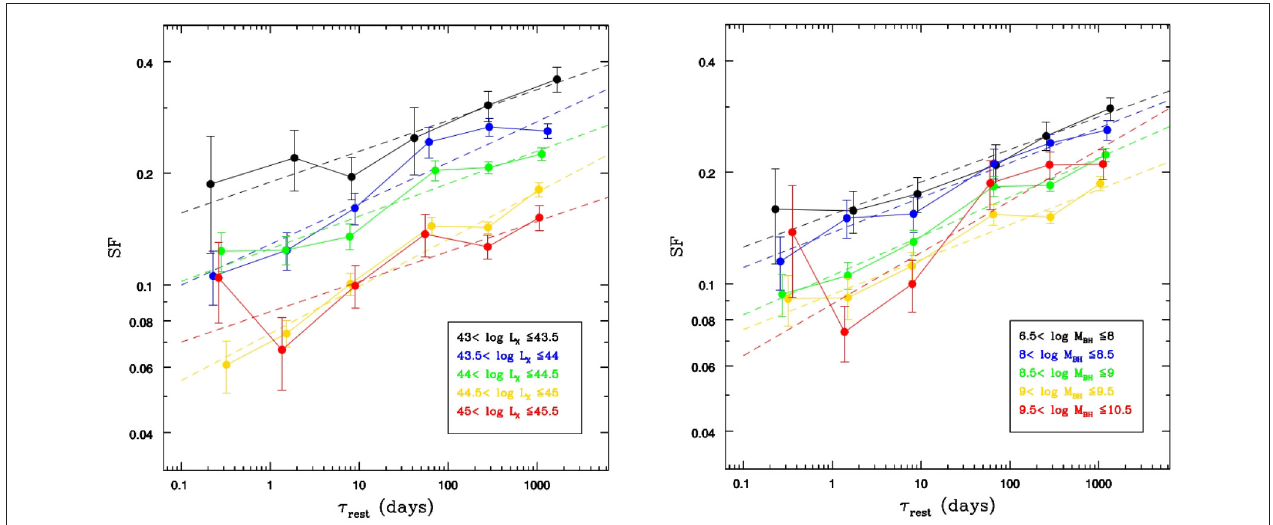
FIGURE 1 | The structure function in bins of X-ray luminosity L X and black hole mass M BH (data and continuous lines) with power-law fits (dashed lines). Left panel: Black, 43 < log L X ≤ 43.5; blue, 43.5 < log L X ≤ 44; green, 44 < log L X ≤ 44.5; yellow, 44.5 < log L X ≤ 45; red, 45 < log L X ≤ 45.5. Right panel: Black,